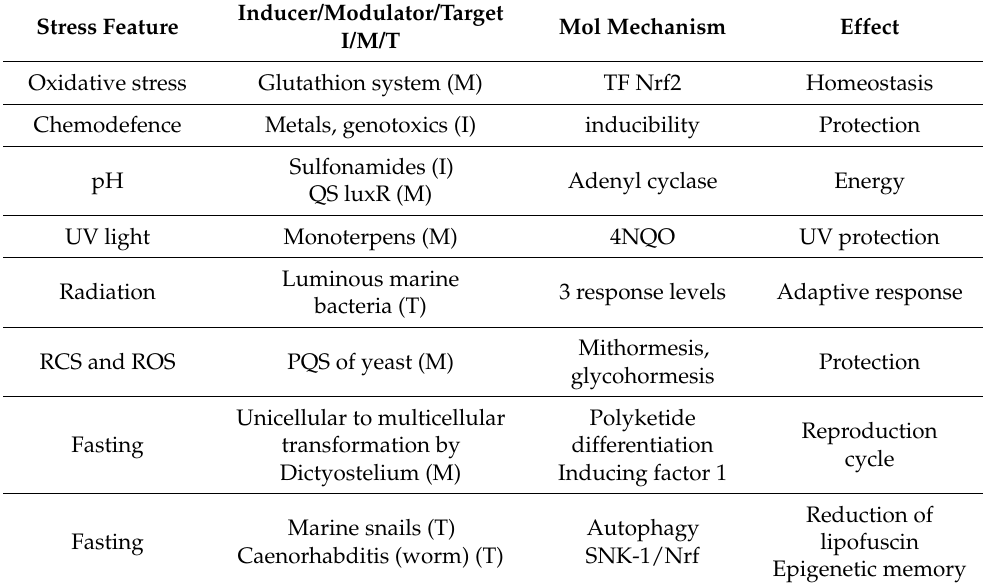
Table 1. Evolutionary aspects of